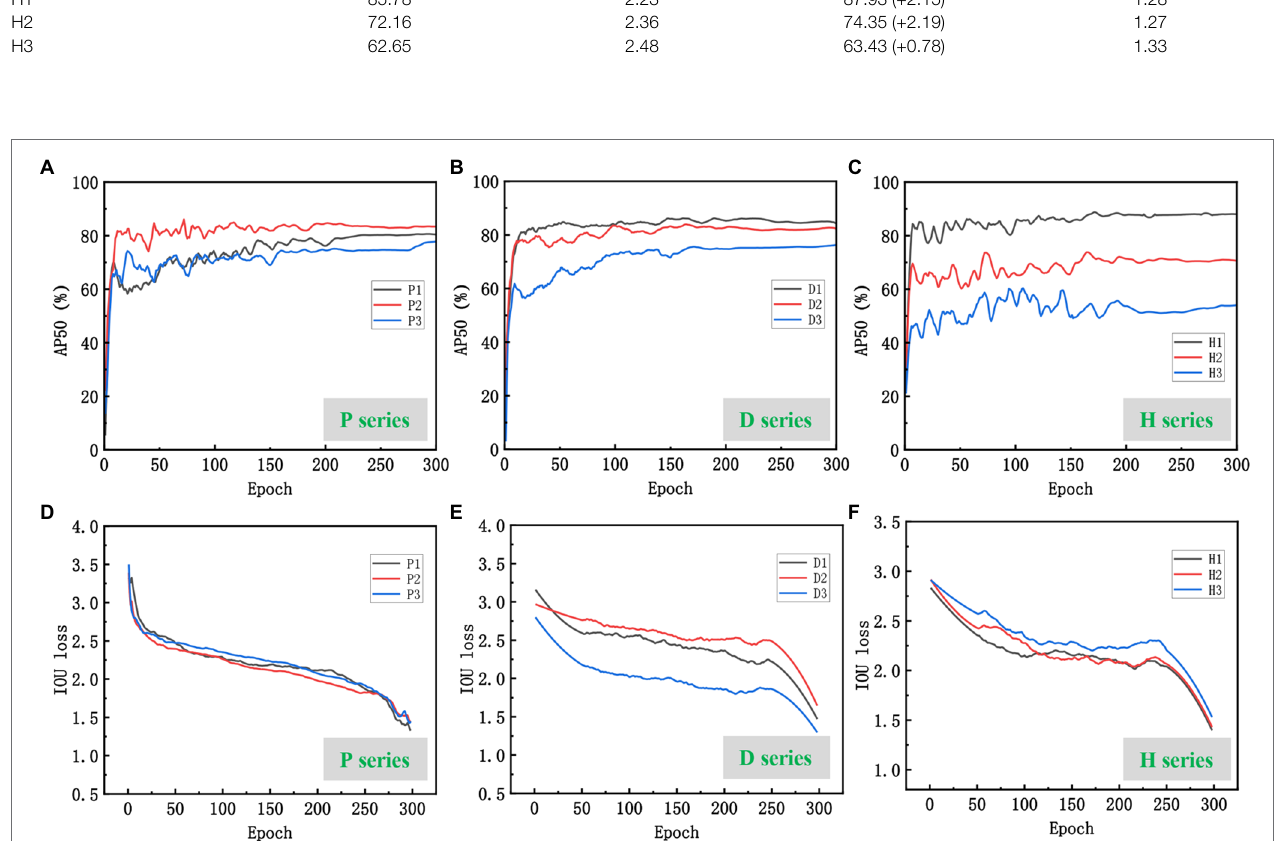
FIGURE 8 | Performance of the improved model on the three series datasets: (A–C) are AP50 curves for the three series datasets; (D–F) are IOU loss curves for the three series